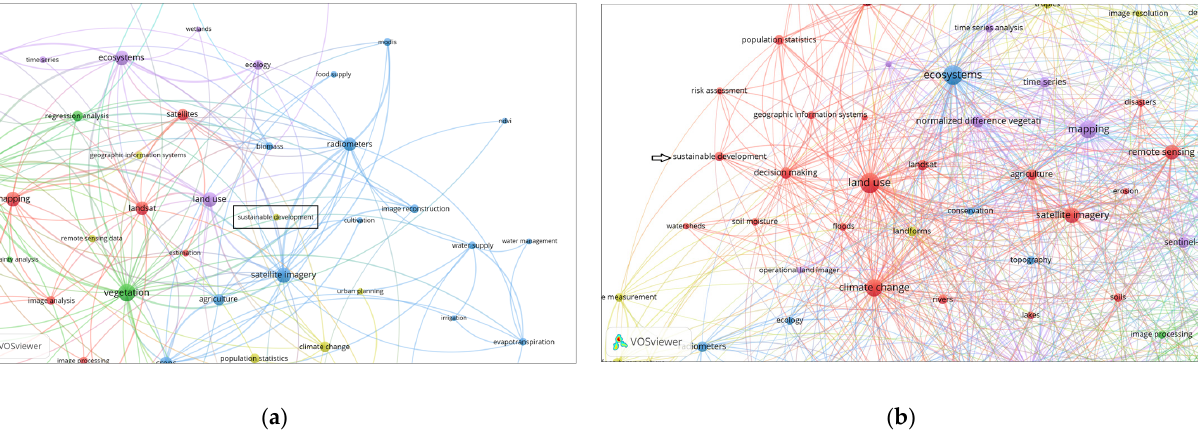
Figure 7. ( a ) VOSviewer results of co-occurrences in papers published in Remote Sensing 2009–2021 with key terms “sustain” or “sustainable development”; display shows enlarged output solely for term ‘sustainable development’; ( b ) VOSviewer results of co-occurrences in papers published in Remote Sensing solely in 2021 with key terms “sustain” or “sustainable development”; display shows enlarged output solely for “sustainable development”: see Appendix A.2 for details.